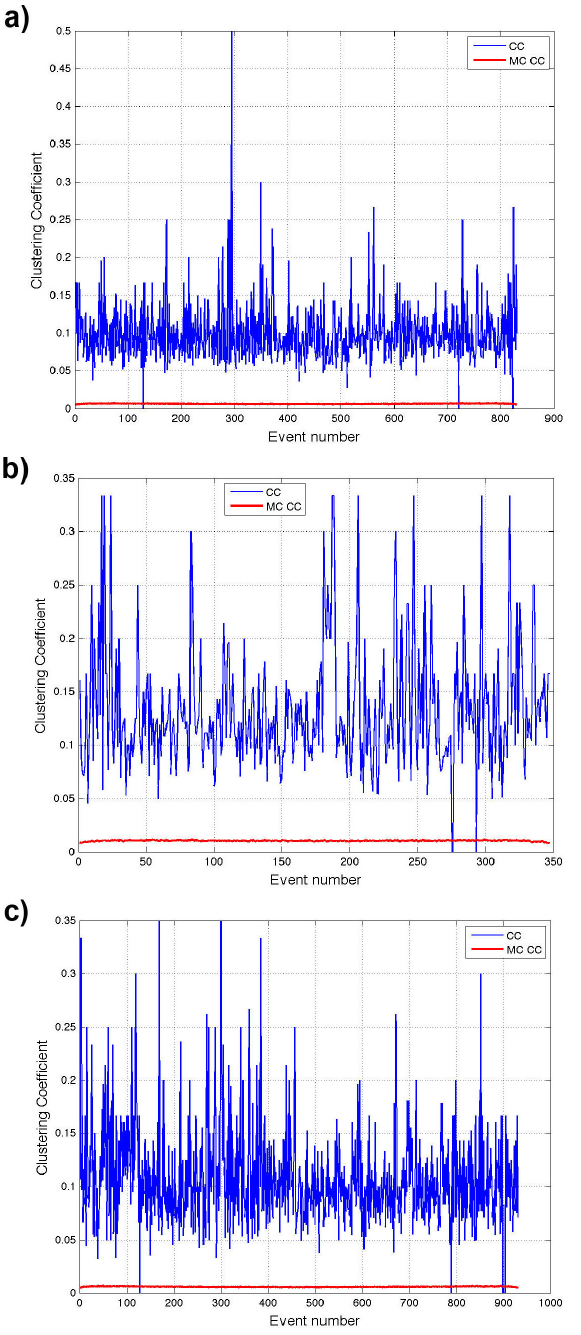
Fig. 6. Clustering coefficients of binary directed recurrence net- work of events using Fagiolo’s approach (1997). The clustering coefficient used here is the sum of “in”, “middleman”, and “out” contributions of the triad discussed in the text. (a) Region 1; (b) Region 2; (c) Region 3.